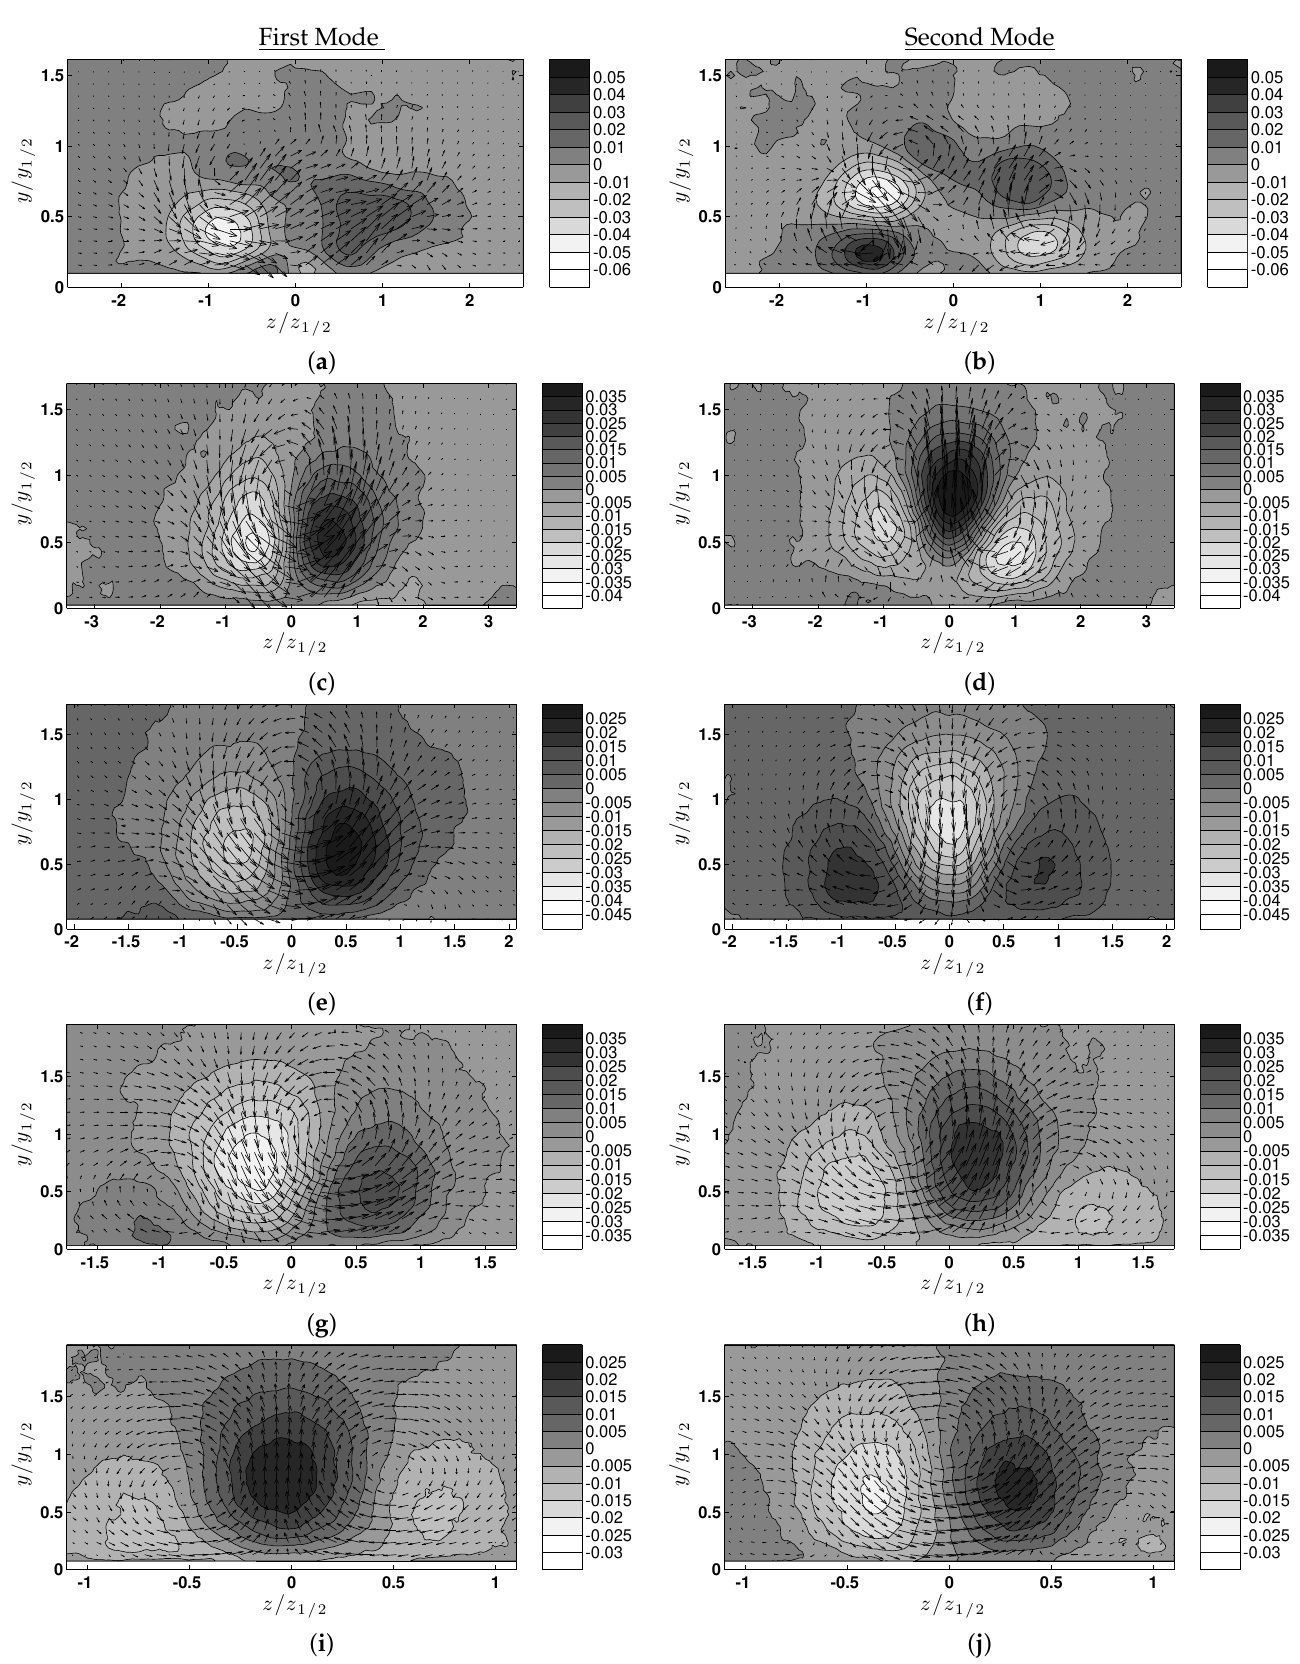
Figure 3. Comparison of the first and second POD eigenmodes: ( a ) and ( b ) x / D = 5, ( c ) and ( d ) x / D = 10, ( e ) and ( f ) x / D = 15, ( g ) and ( h ) x / D = 20, and ( i ) and ( j ) x / D =